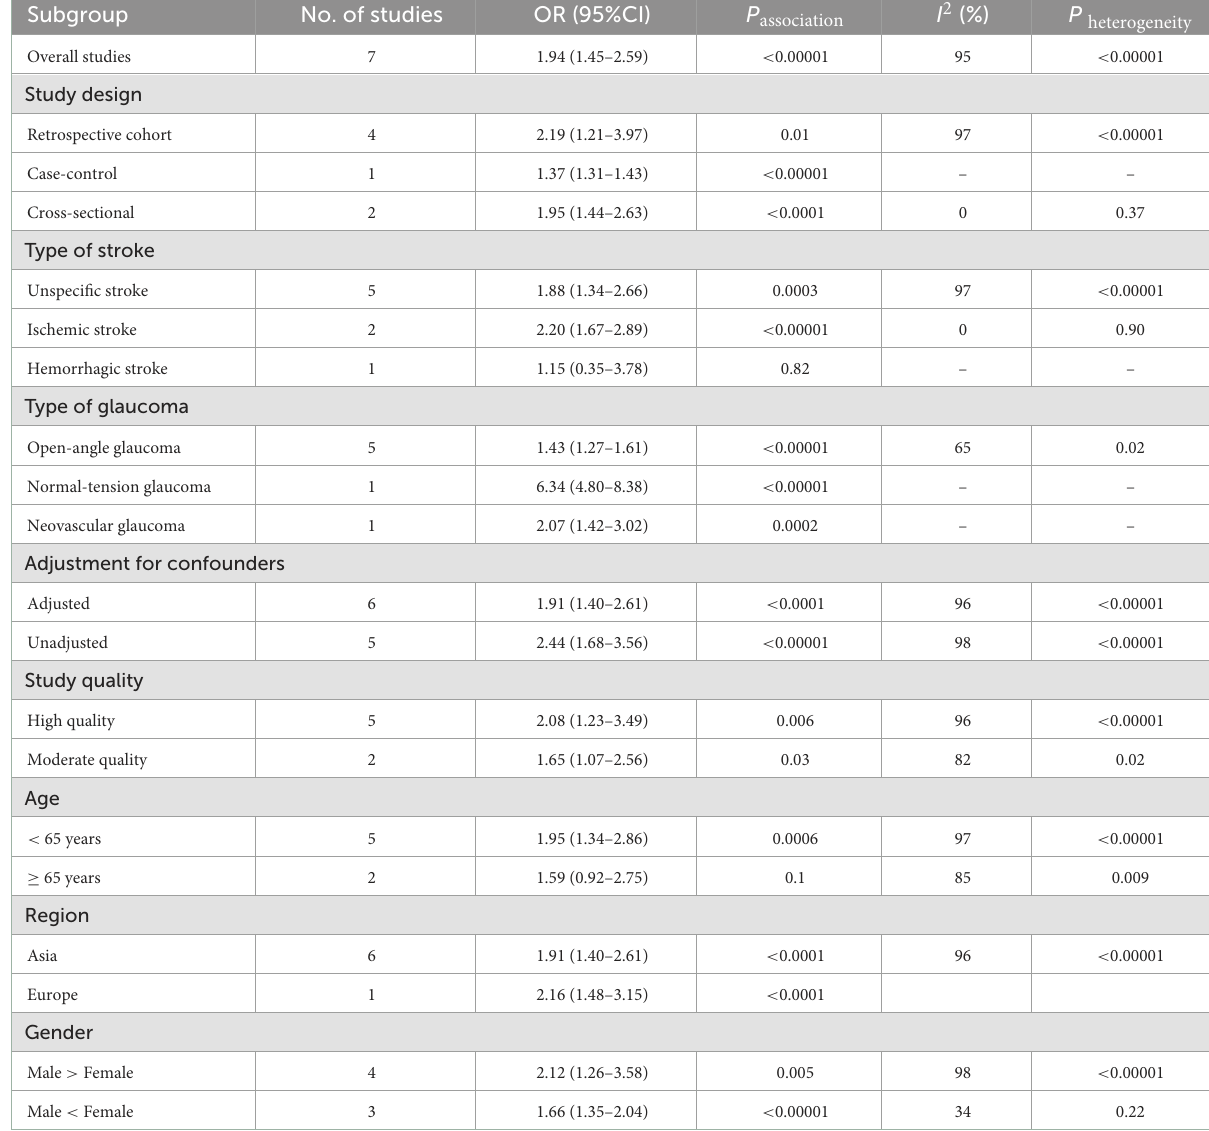
TABLE 2 Subgroup analyses of association between glaucoma and risk of stroke.